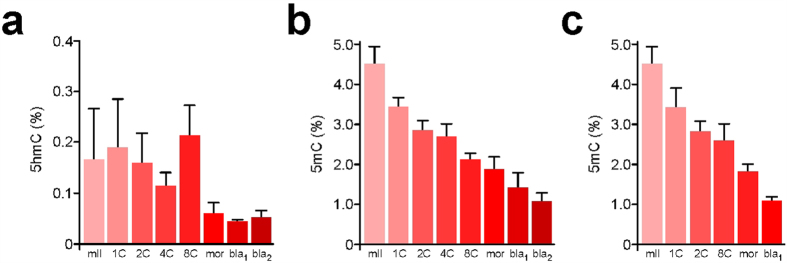
Quantification by SMM of 5 hmC during mouse preimplantation development.(a) Content (% total G) of 5 hmC (Y-axis) in metaphase II oocytes (mII) and preimplantation embryos at different preimplantation developmental time points. bla1 and bla2 respectively refer to blastocysts ~84 h and ~96 h post-fertilization. Mean values are ±sd (3 ≤ n ≤ 5). Embryos were produced by natural mating. 5 mC levels in embryos produced by natural mating (b) or IVF (c) are shown for comparison, with mean values shown ±sd (3 ≤ n ≤ 7). Embryo numbers are given in Supplementary Table S1.